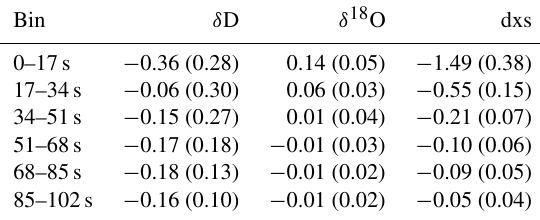
Table 5. The average bias and the standard deviation of the mean (‰) for 50 determinations of isotopic step-change corrections us- ing mock ice (i.e., δ D step-change values of approximately − 240 to − 120‰). Each data bin includes 20 consecutive data points (span- ning ∼ 17s of analysis time), increasing from c n = 0.5. The data in each bin are averaged for each determination. Corrected values of dxs are calculated from the corrected δ D and δ 18 O values. From c n = 0.5, about 100s is needed to achieve greater than 98% of the expected mock ice value of − 120‰. For comparison, the calcula- tion of the standard deviation of the mean for 50 determinations of 17s averages of isotopically homogenous water yields values for δ D, δ x O, and dxs of 0.01, 0.01, and 0.05‰, respectively. The iso- topically homogenous water was allowed to run through the CRDS- CFA system for 1h before the 17s averages were determined.